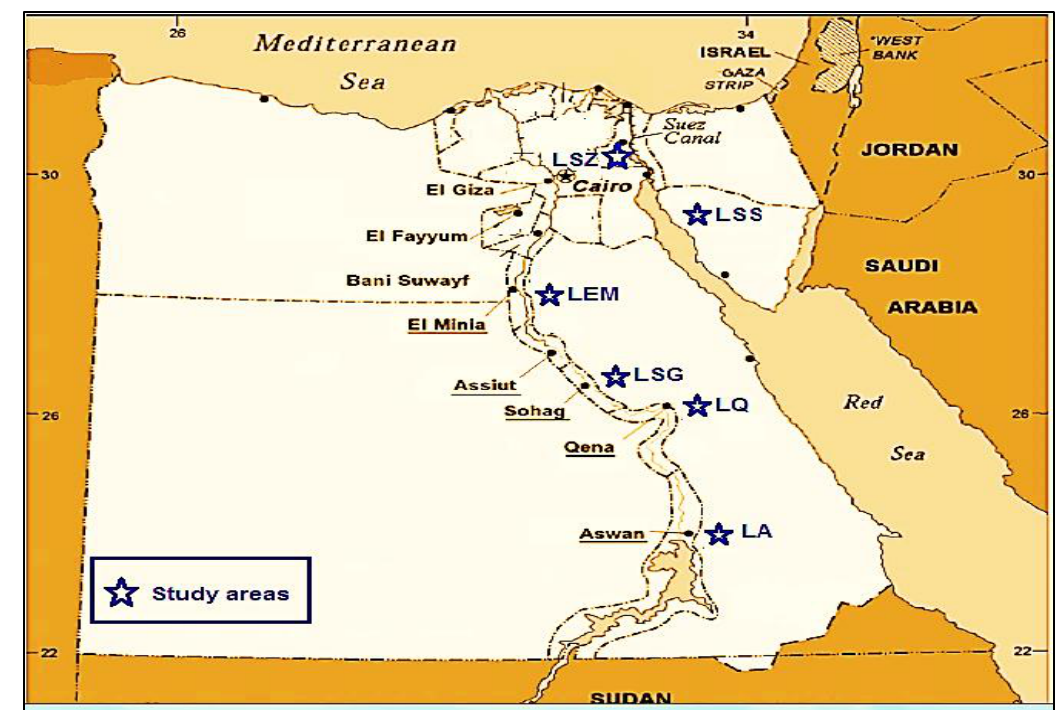
Figure 1. Location map of the studied limestone specimens . Table 1. Petrographic features of the tested limestone rocks . Table 2. XRF analysis of the studied